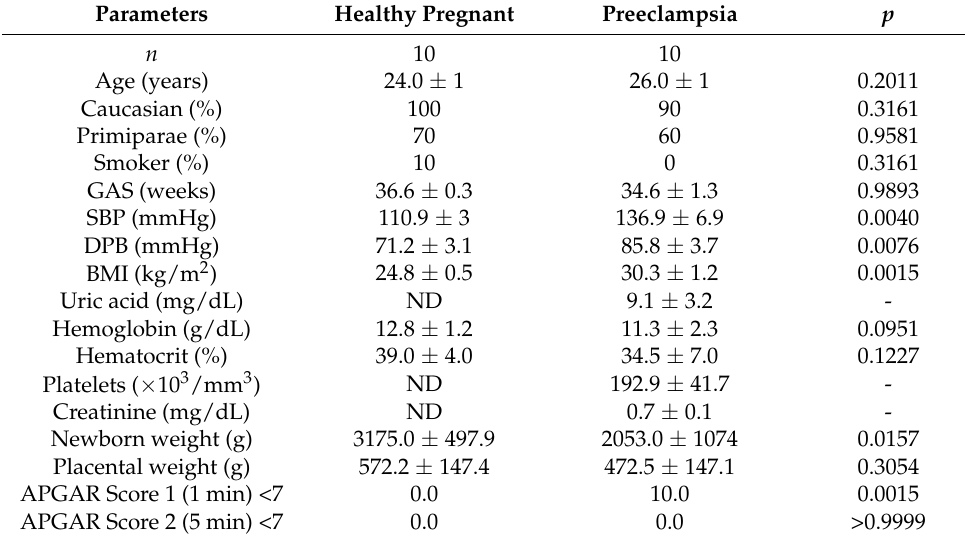
Table 1. Clinical parameters of the